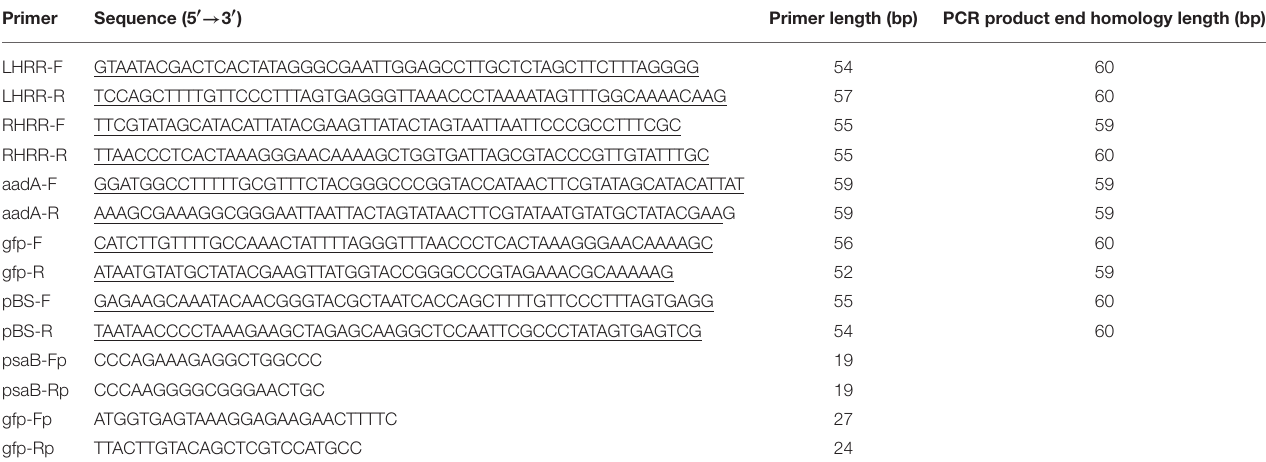
TABLE 1 | Oligonucleotide sequences used in this study (homologous sequences are underlined). Primer Sequence (5 ′ → 3 ′